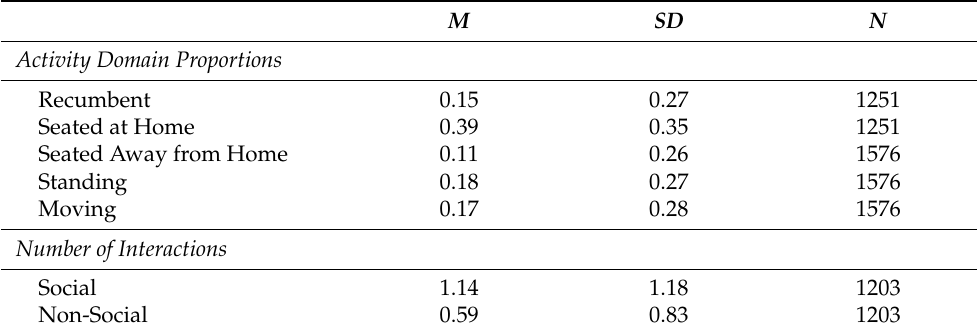
Table 2. Baseline Scores on Activity Domains and Interaction Variables. M SD